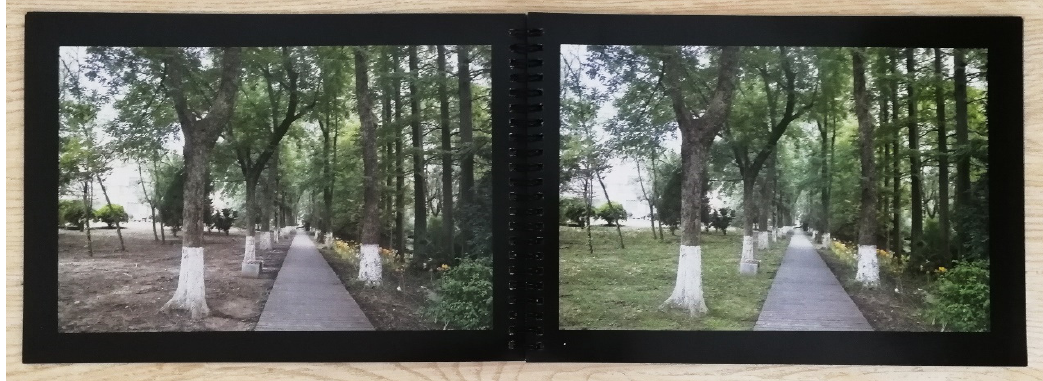
Figure 10. Photo of the booklet in side-by-side format.